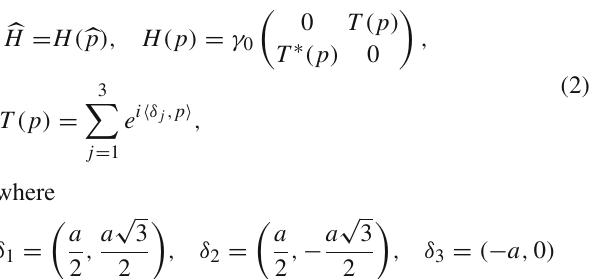
Fig. 4 Graphene tube